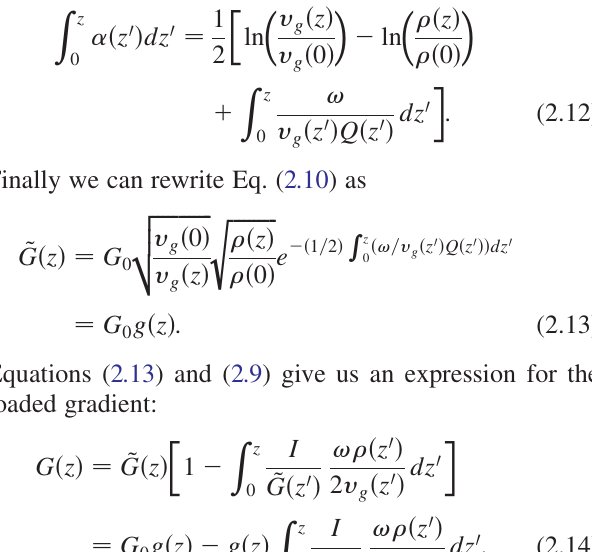
FIG. 3. Loaded (red) and unloaded (blue) gradients calculated accurately (solid) and approximately (dashed) for the CLIC main linac accelerating structure. In blue circles, the unloaded gra- dient calculated numerically is